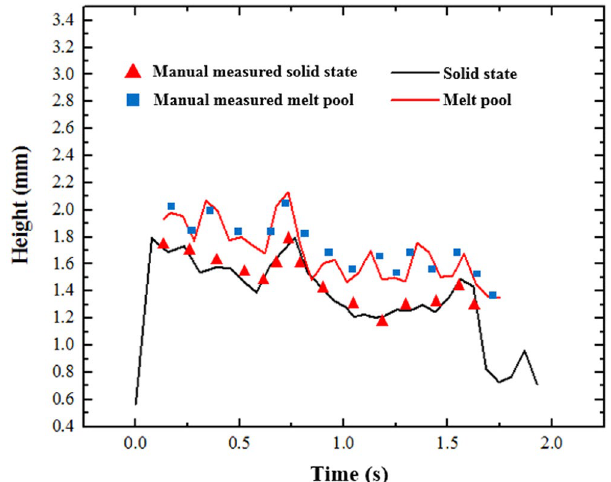
Figure 5. The height of melt pool and solidified